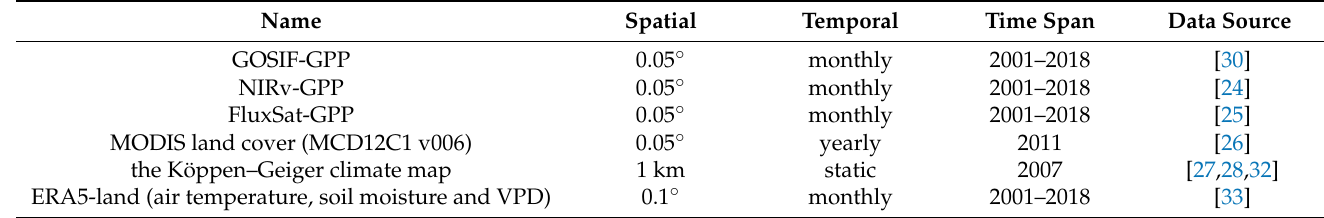
Table 2. Main data sets used in the study. Bilinear interpolation was used to convert the ERA5land climate data from 0.1 ◦ to 0.05 ◦ . The time-span of the analysis (2001–2018) was confined by the availability of the GPP-data